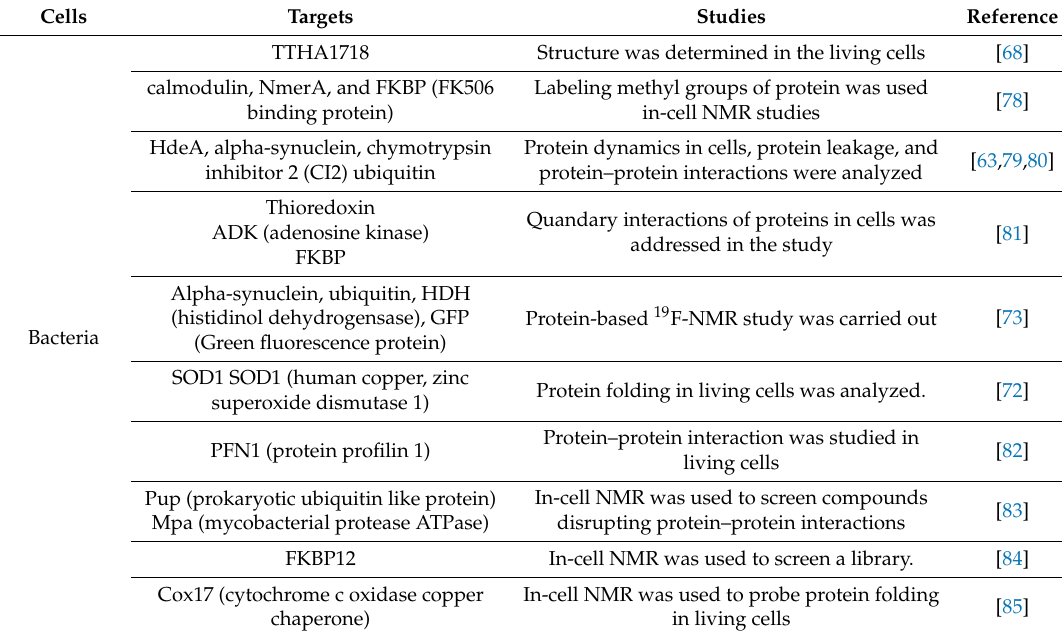
Table 2. In-cell NMR studies of proteins in different